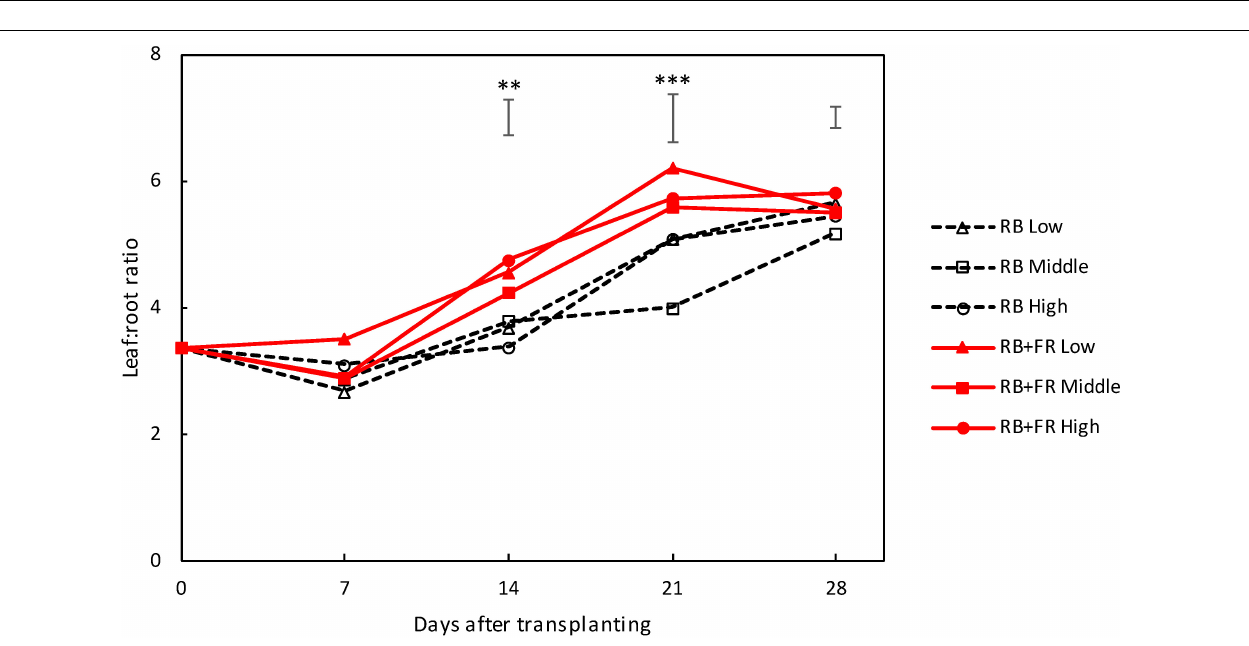
FIGURE 3 | Time course of total dry weight of lettuce plants (g plant − 1 , upper layer) and plant leaf area (cm 2 plant − 1 , lower layer) when grown without (RB) or with (RB + FR) 52 µ mol m − 2 s − 1 far-red radiation (FR) intensity, at three planting densities (low, middle, and high being 23, 37, and 51 plants m − 2 , respectively). Solid lines represent RB + FR treatment and dashed lines indicate RB treatment. Bars on top of each day represent least significant difference. Significant effect of FR: ∗ P < 0.10, ∗∗ P < 0.05, and ∗∗∗ P < 0.01 Data are means of three blocks ( n = 3) each with four–six replicate plants.